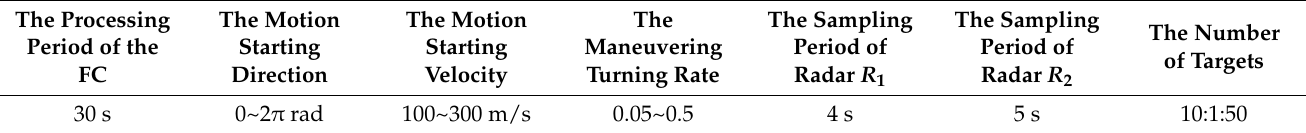
Table 6. The parameter settings for simulation scenario 2.